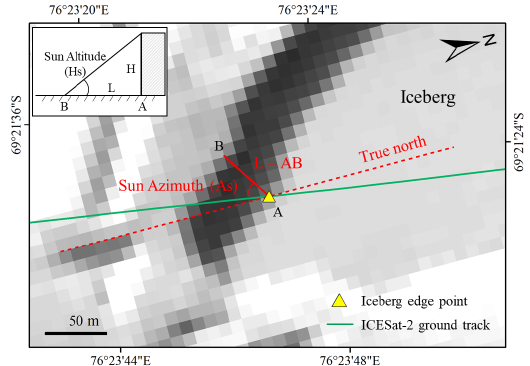
Figure 3 . The geometric relationship between iceberg height (H), shadow length (L) along sun azimuth (As), and sun altitude (Hs). Take the iceberg “c” in Figure 1 as an example.